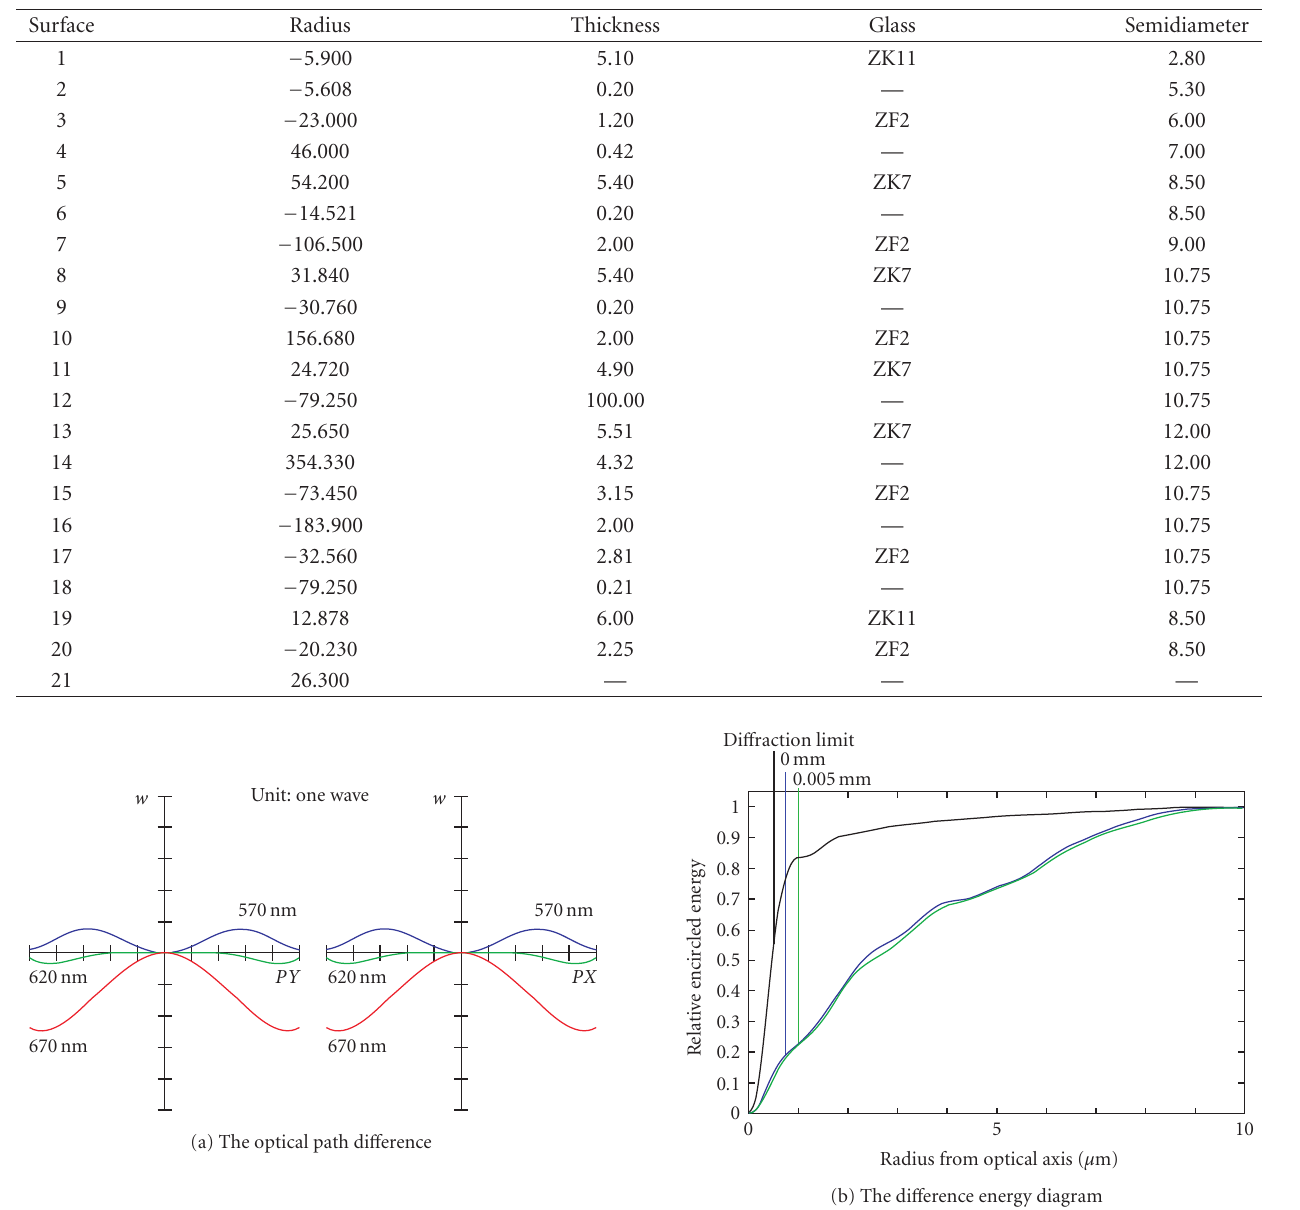
Figure 4: The optical path di ff erence and the encircled energy diagram of the